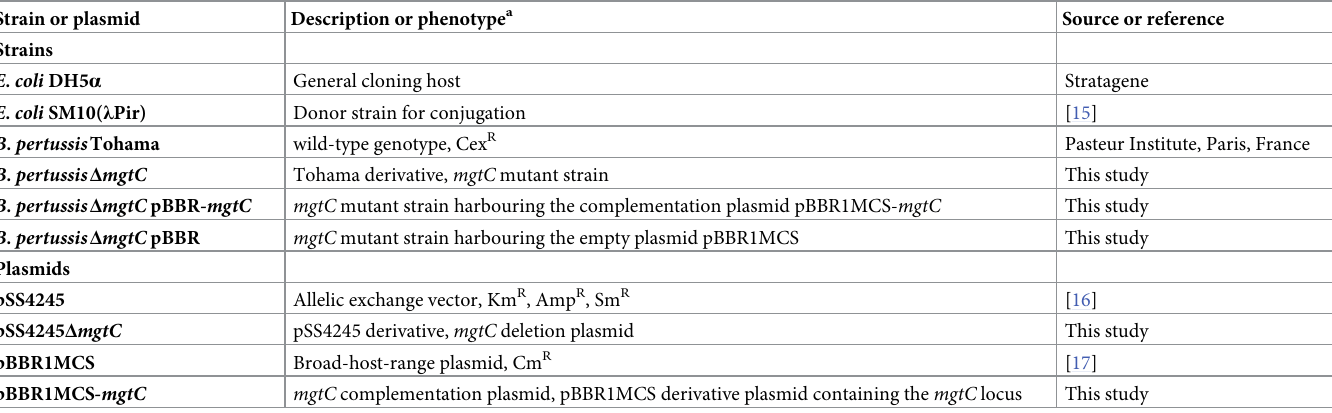
Table 1. Strains and plasmids used in this